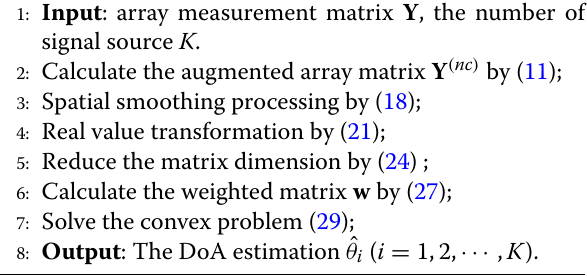
Algorithm 1 The proposed sparse DoA estimation algo- rithm for non-circular signal